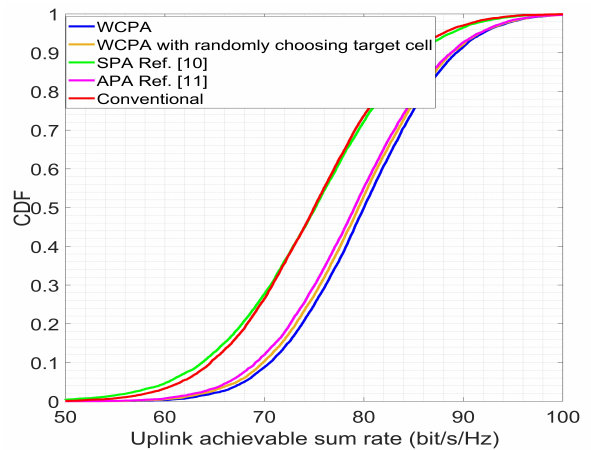
Figure 4. Average uplink achievable sum rate in case K = 8, S = 12.